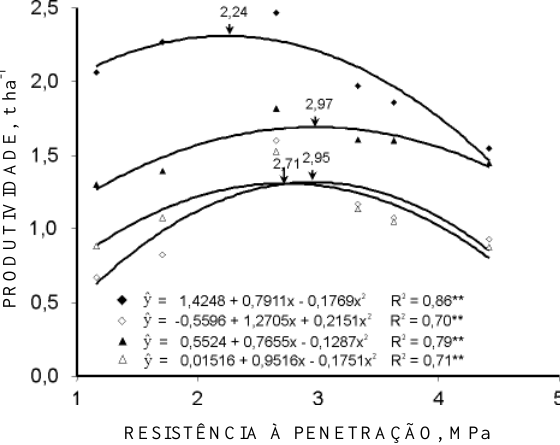
Figura 1. Produtividade de cultivares de soja, considerando a resistência do solo à penetração, em Latossolo Vermelho. ( ) IAC Foscarim 31; ( ) MG/BR 46 (Conquista); ( ) BRS/MG 68 (Vencedora); ( ΔΔ ΔΔ Δ ) IAC